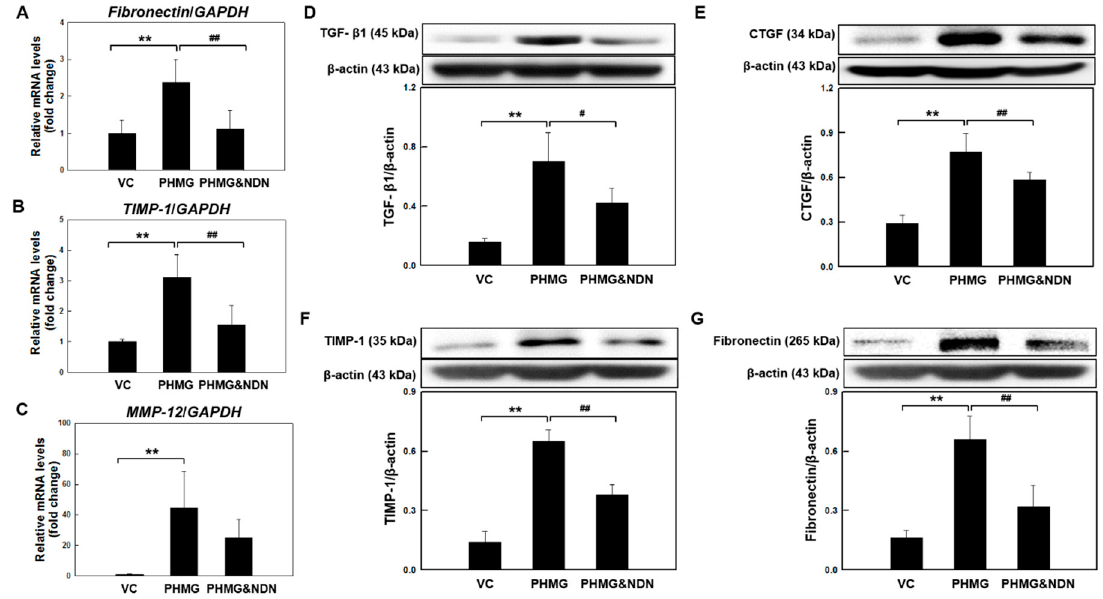
Figure 5. Effect of NDN on fibrotic factors expression of mice. The expression levels of fibronectin, TIMP-1, and MMP-12 mRNA were determined using qRT-PCR ( A – C ). The levels of CTGF, TGF- β 1, TIMP-1, and fibronectin expressions in the lung tissues were determined by western blotting ( D – G ). Gene expressions were presented as fold changes and normalized to GAPDH. The blots were analyzed by densitometry and normalized to β -actin. Data are expressed as means ± SD ( n = 6/group). ** p < 0.01 vs. VC group, # p < 0.05 and ## p < 0.01 vs. PHMG group.